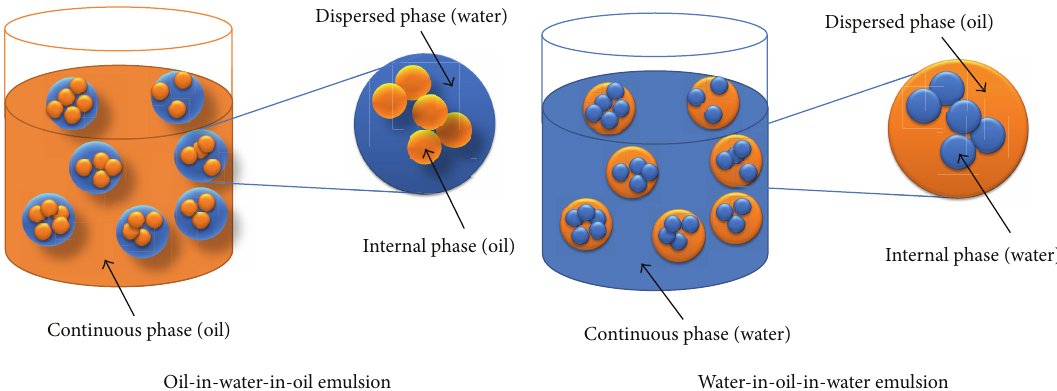
Figure 1: Concept of three-phase oil-in-water-in-oil and water-in-oil-in-water